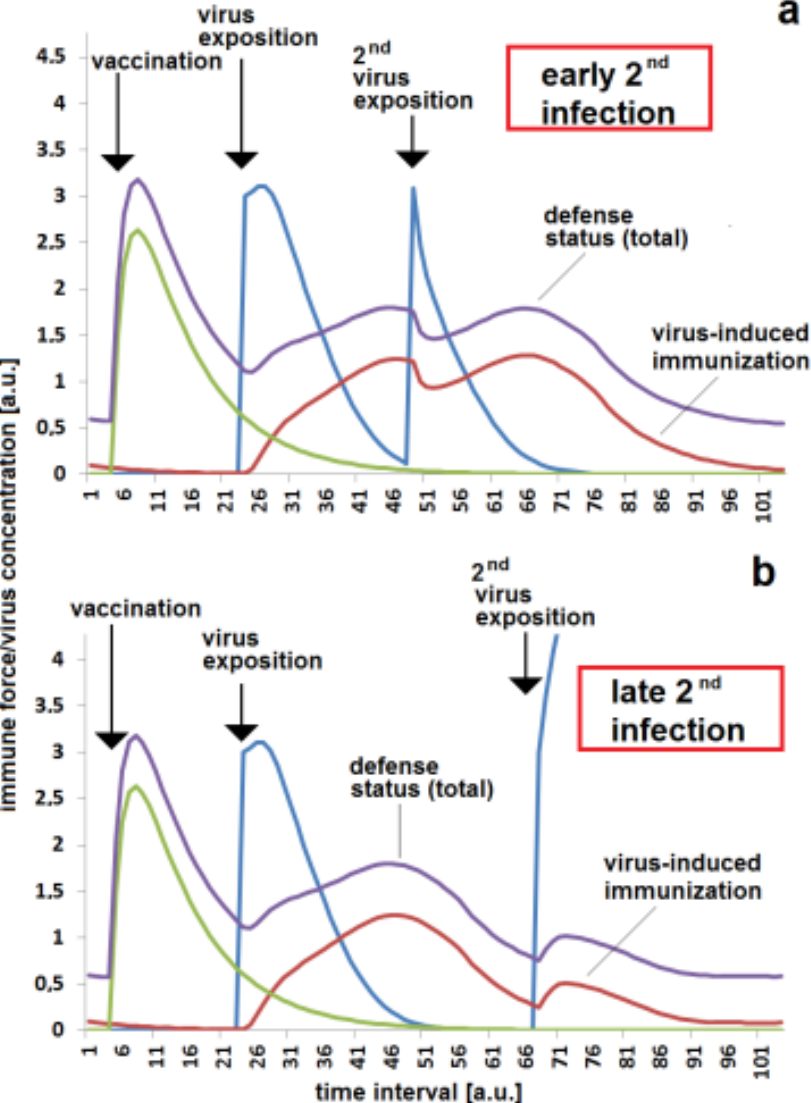
Figure 6. Parameter-dependent requirement of third immunization—either by virus contact or by vaccination— given in time: ( a ) successful defense of infection shortly after second activation of immune response by virus exposition; ( b ) disease breakthrough after first immunization by vaccination and re-activation of immune response by a virus exposition, resulting in a fended-off infection due to missing third immunization by vaccination. The same set of parameters were used for all simulations ( a , b ): k vir = 0.3; k r = 0.2; k st = 0.15; D vacc = 0.4; D AB = 0.1; c BGim = 0.5; v oo = 30; st oo = 10.